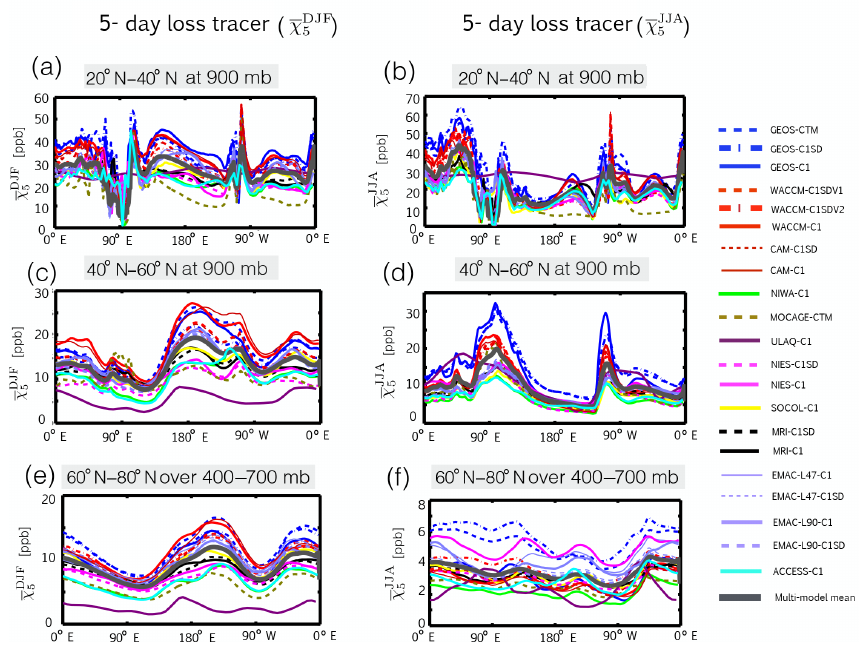
Figure 5. Zonal profiles of the climatological mean 5-day idealized loss tracer χ 5 averaged over 900hPa and over latitudes spanning 20– 40 ◦ N (a, b) and 40–60 ◦ N (c, d) and over 400–700hPa over latitudes between 60 and 80 ◦ N (e, f) . Profiles are shown for DJF (a, c, e) and JJA (b, d, f) . Dashed lines correspond to the REF-C1SD simulations, which are constrained with analysis meteorological fields, while solid lines correspond to the free-running REF-C1 simulations. The thick dark grey line represents the multi-model